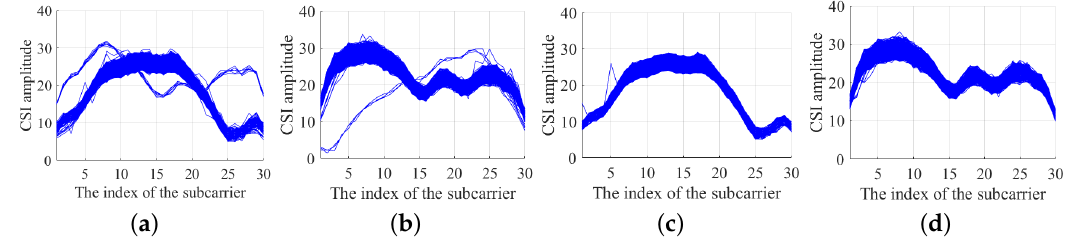
Figure 5. CSI data processing. ( a , b ) are original data; ( c , d ) are processed